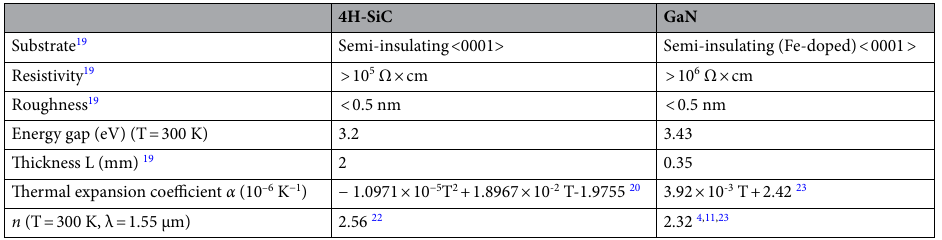
Table 1. Main features of the 4H-SiC and GaN samples.